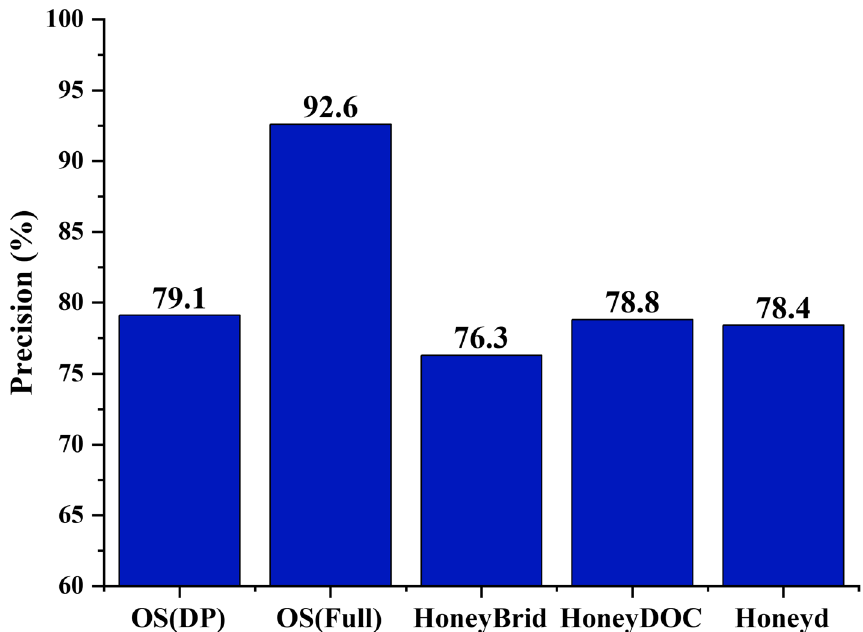
Fig. 11 Comparison of system identification traffic precision